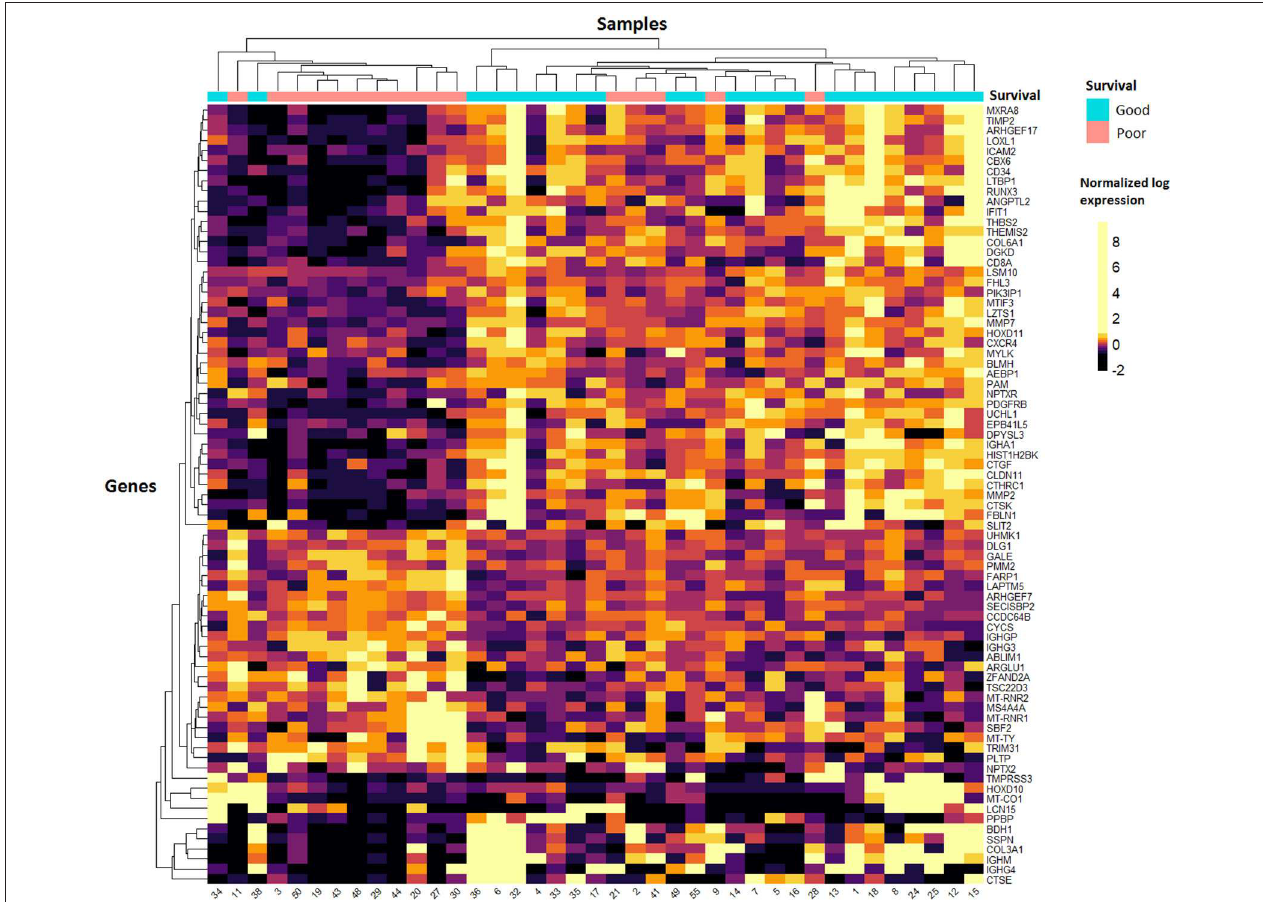
FIGURE 1 | Heatmap of tumour samples. Unsupervised clustering of the 77 genes with the lowest FDR values in DESeq2 analysis. Samples are shown on the x-axis and the 77 genes on the y-axis. A quantile colour scale is used with 10 different colours ranging from black (low expression) to yellow (high expression).